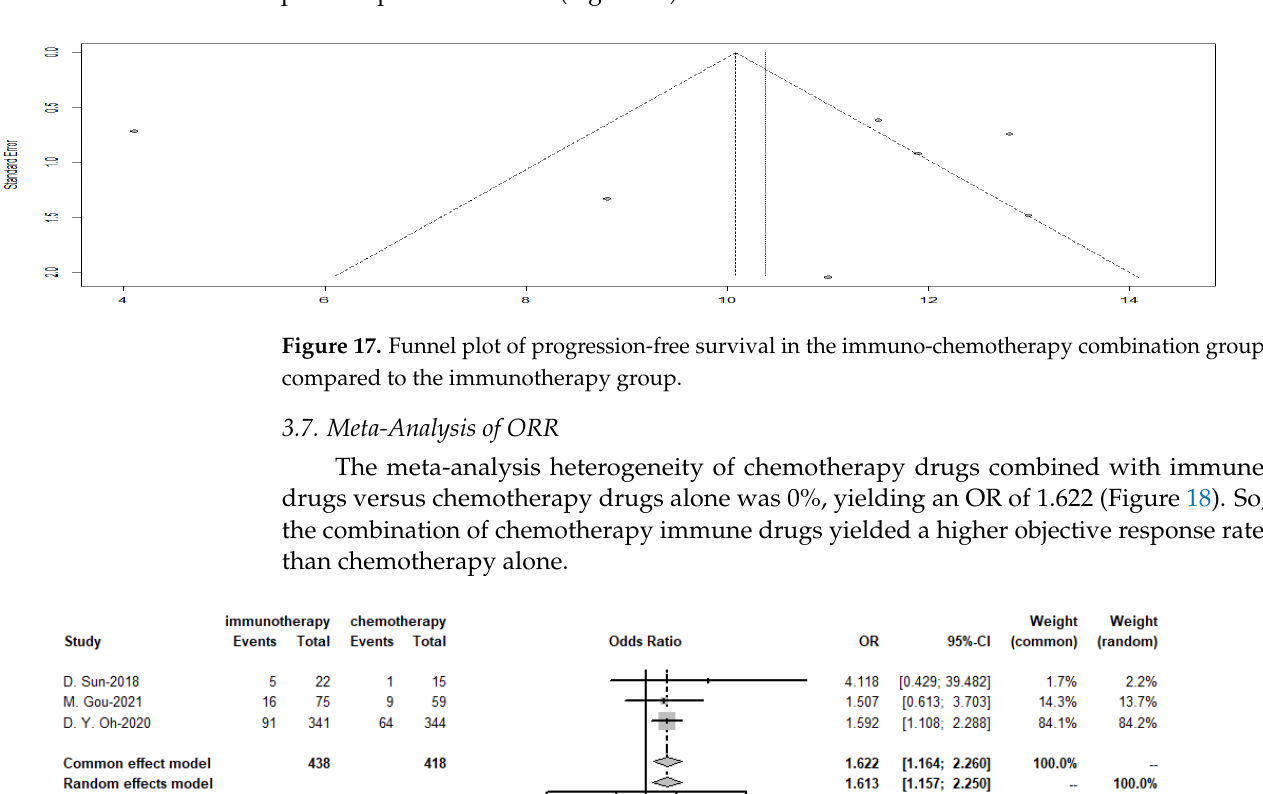
Figure 18. Objective response rate in the immuno ‐ chemotherapy combination group compared to the chemotherapy drug alone group.